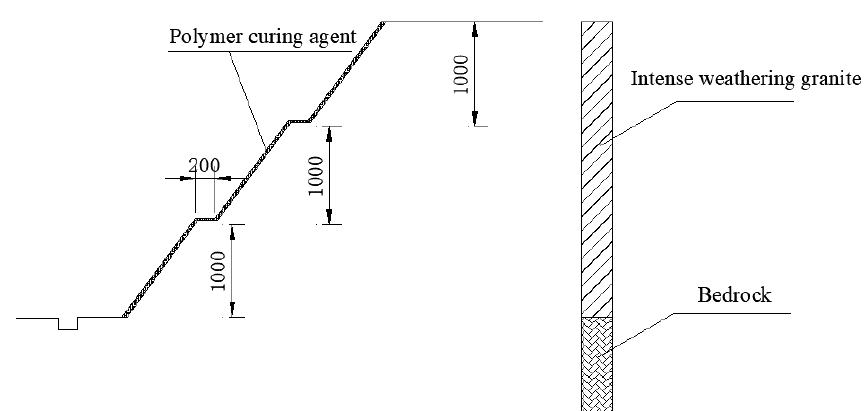
Figure 1. Slope engineering section.